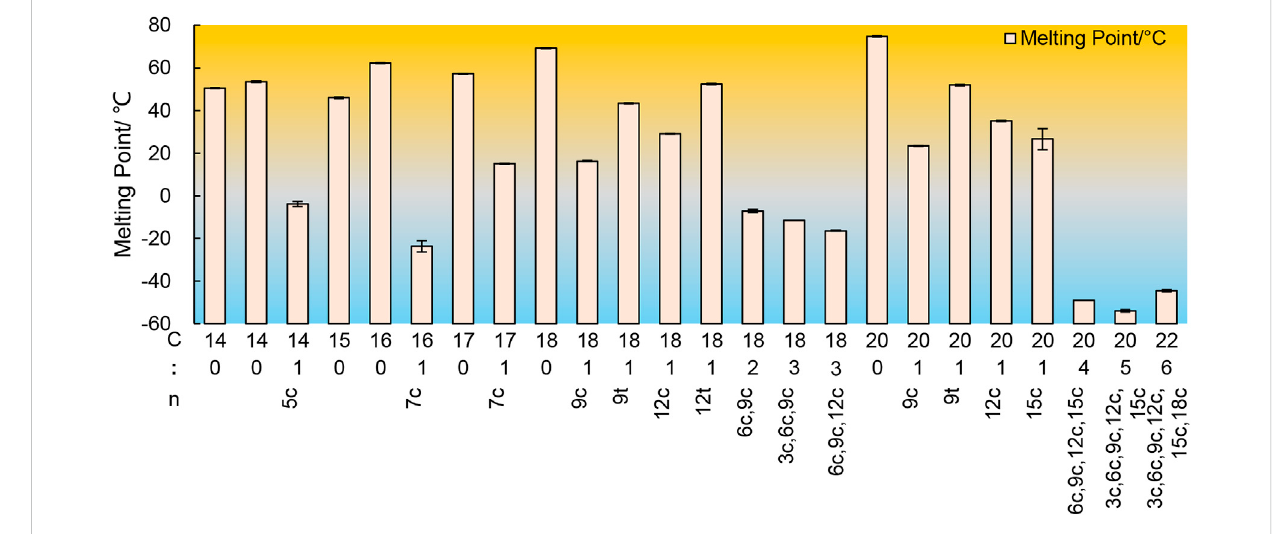
FIGURE 6 The melting points of some free fatty acids.